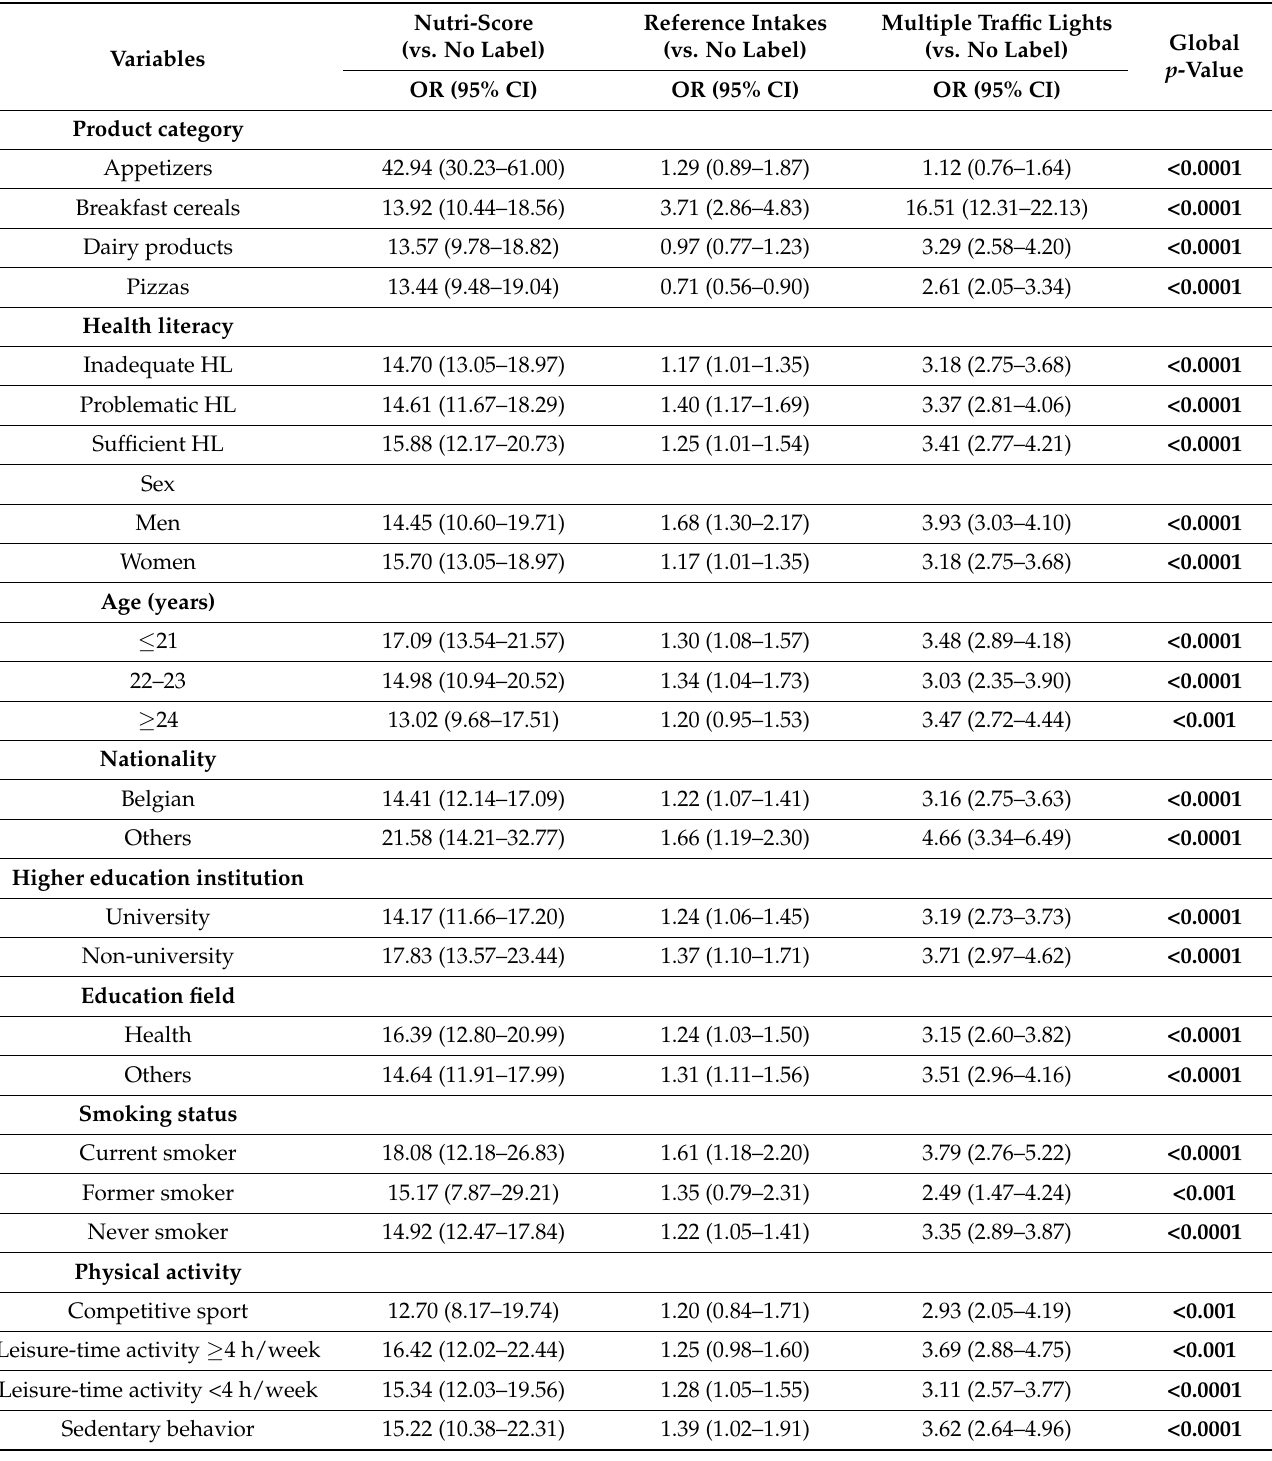
Table 3. Mixed logistic regression models showing the association between objective understanding and FOP labels, across subgroups at